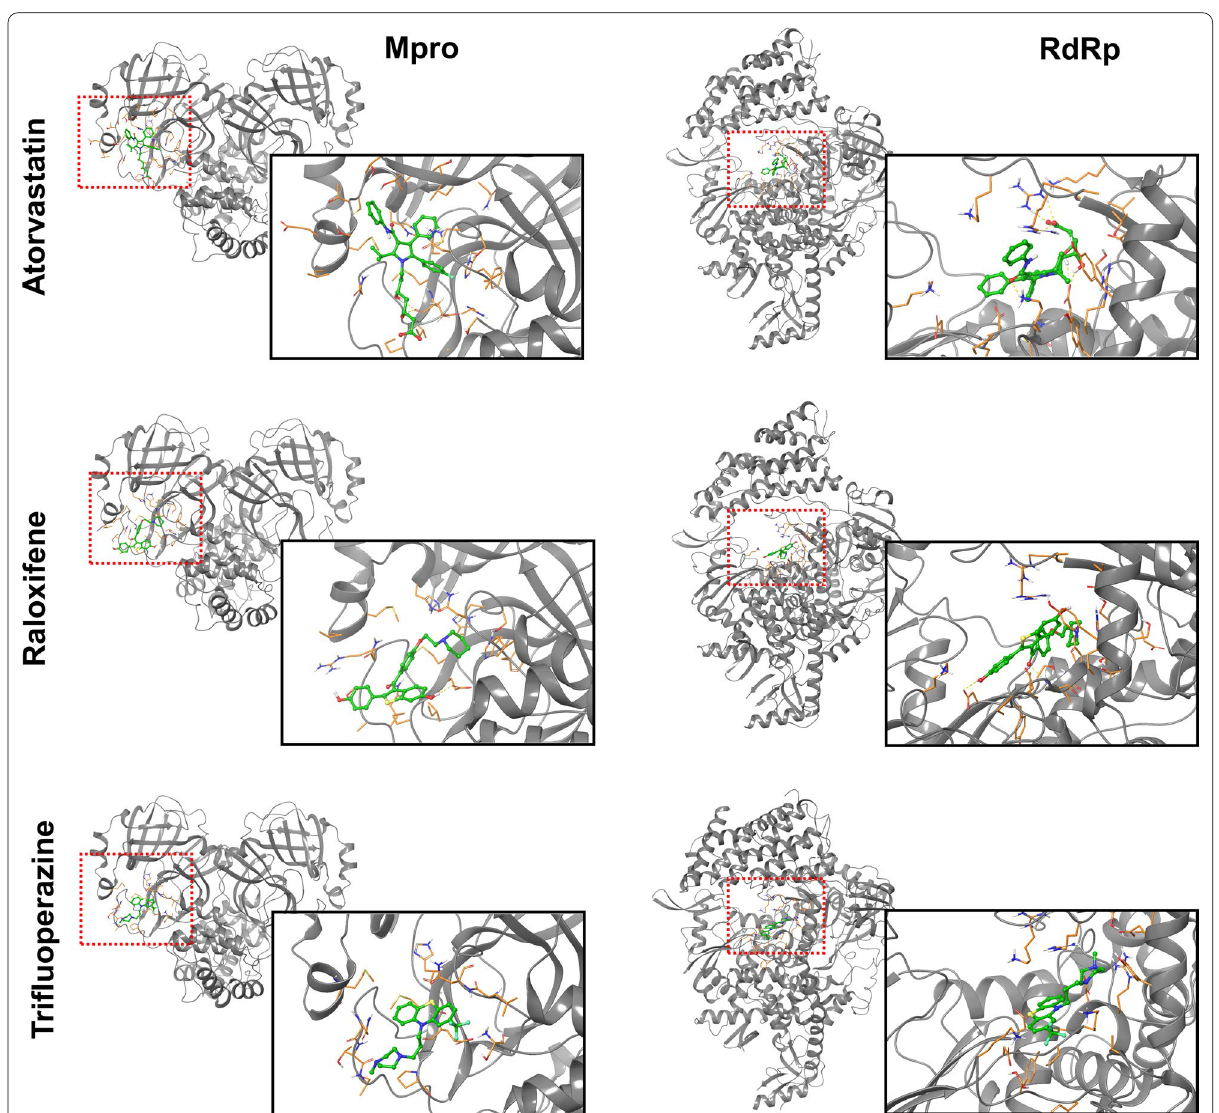
Fig. 2 Visualization of the predicted interactions between atorvastatin, raloxifene and trifluoperazine, and the SARS-CoV-2 Mpro (left panel) and RdRp (right